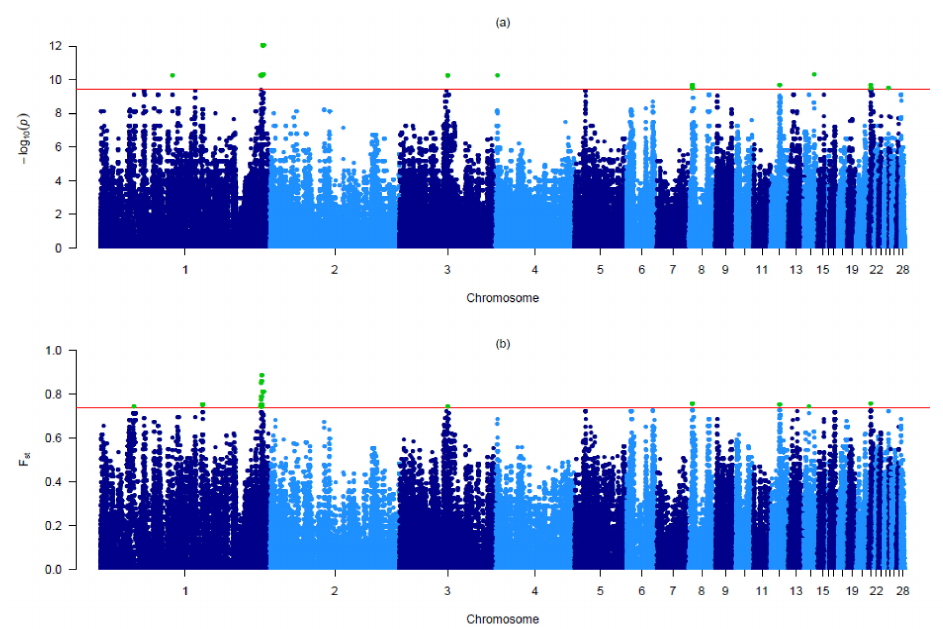
Figure 2. ( a ) Manhattan plot of the p -values in the genome-wide association study (GWAS). The horizontal lines represent the Bonferroni-corrected genome-wide significance (red; p < 0.0001); ( b ) Manhattan plot of the genome-wide fixation index ( F ST ). The horizontal line represents the genome-wide significance single nucleotide polymorphisms (SNP) above the 99.98th percentile distribution) ( F ST = 0.74). Significant SNPs are highlighted in green.